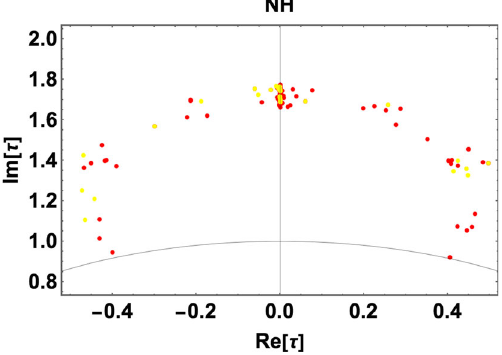
Fig. 5 Allowed region of Majorana phases α 21 in terms of α 31